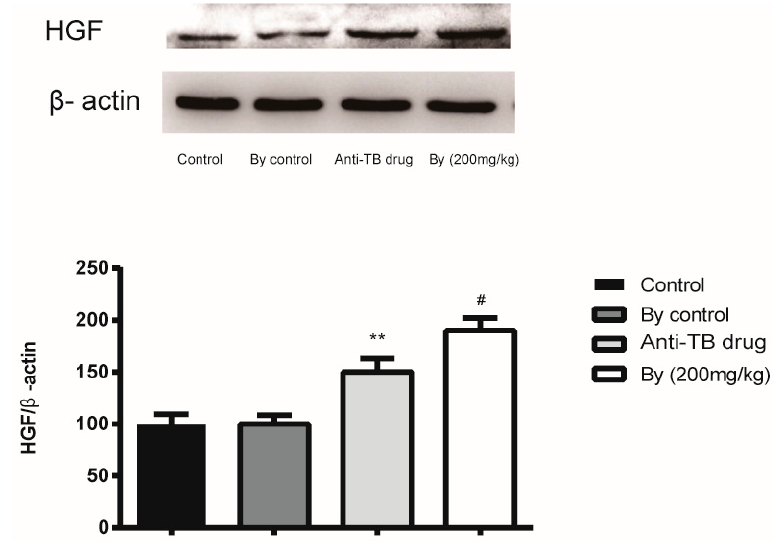
Figure 8. Effect of bicyclol (200 mg/kg) on hepatocyte growth factor (HGF) expression in anti-TB drug intoxicated rats. **, p < 0.01 vs. control group; # , p < 0.05 vs. anti-TB drug intoxicated group.